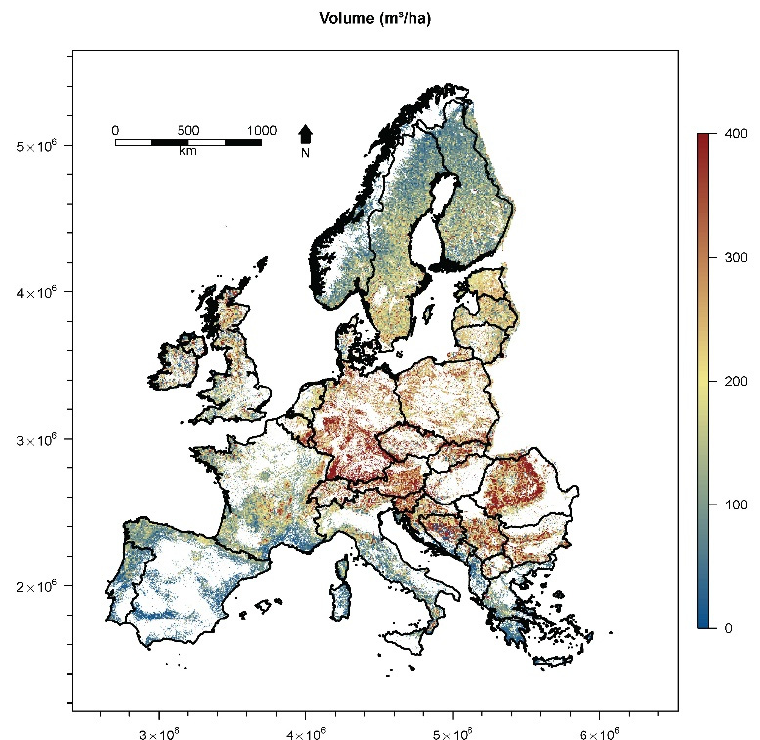
Figure 7. Tree Volume (m 3 /ha) only for 500 × 500 m cells with a minimum tree cover of at least 5% (1.25 ha) according to the MODIS land cover classification. We combined this map with MODIS land cover data to calculate total volume (m 3 ) for each 500 × 500 m cell. Summing up cell values, total volume at regional or country level are estimated. In this figure, values higher than 400 m 3 /ha are truncated for display reasons.